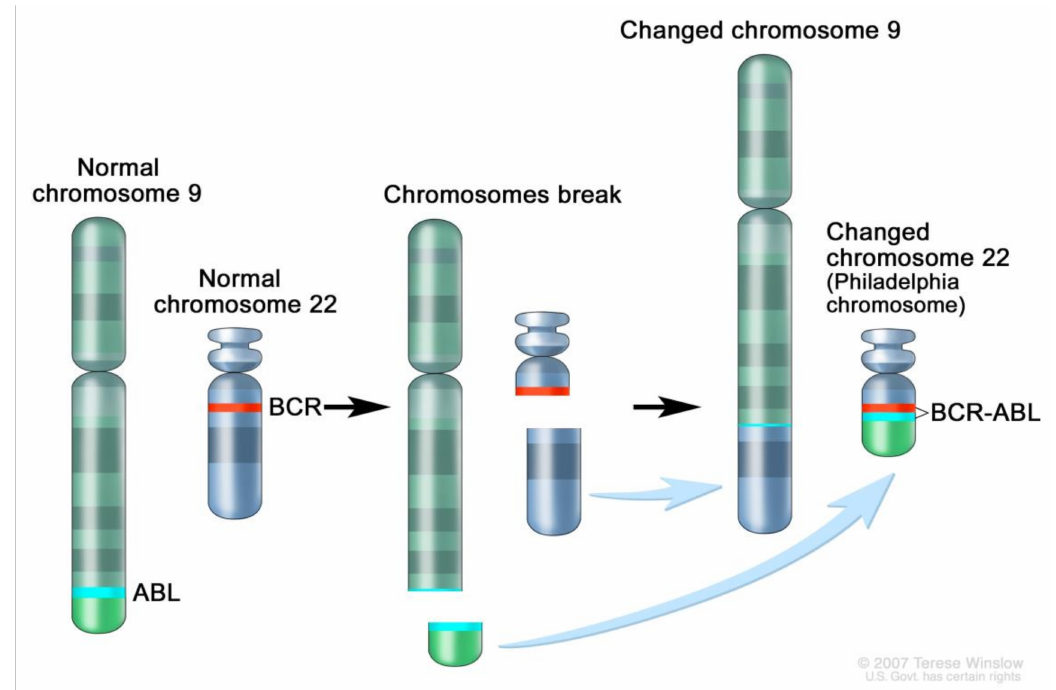
Figure 1. BCR-ABL fusion protein resulting from t(9;22) translocation. BCR-ABL is oncogenic by downstream activation of RAS, MEK and STAT pathways